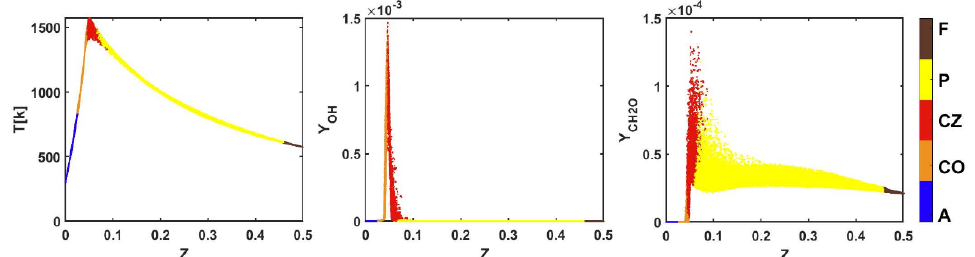
Figure 4. Scatter plot of resolved temperature and mass fractions of OH, CH 2 O in the mixture fraction space in the HM1 case at the height of 60 mm. Colored with five clustering classifications.